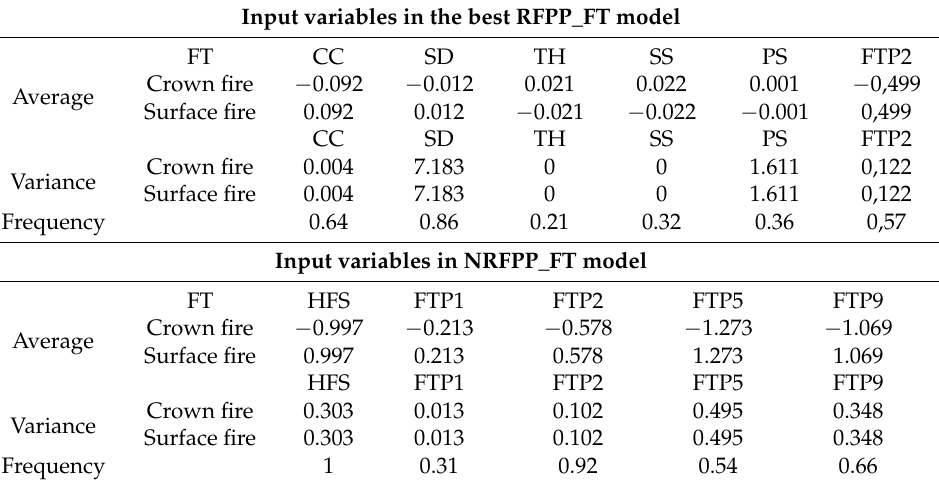
Table 9. Sensitivity analysis of the best models for the classification of Fire Type within reforested and not reforested stands ( P. pinaster ).